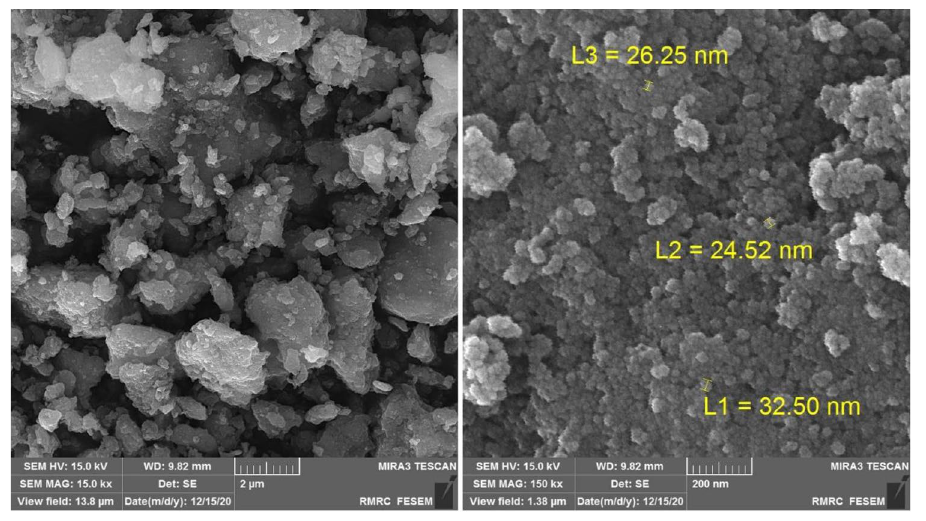
Figure 4. FESEM analysis of